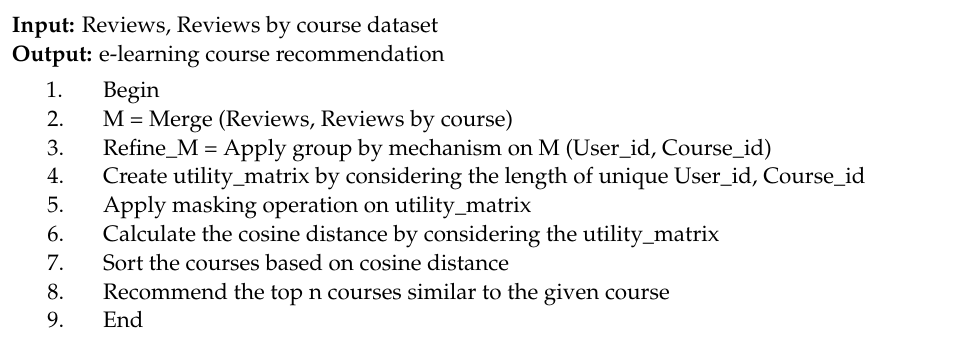
Algorithm 2: SVD for e-learning course